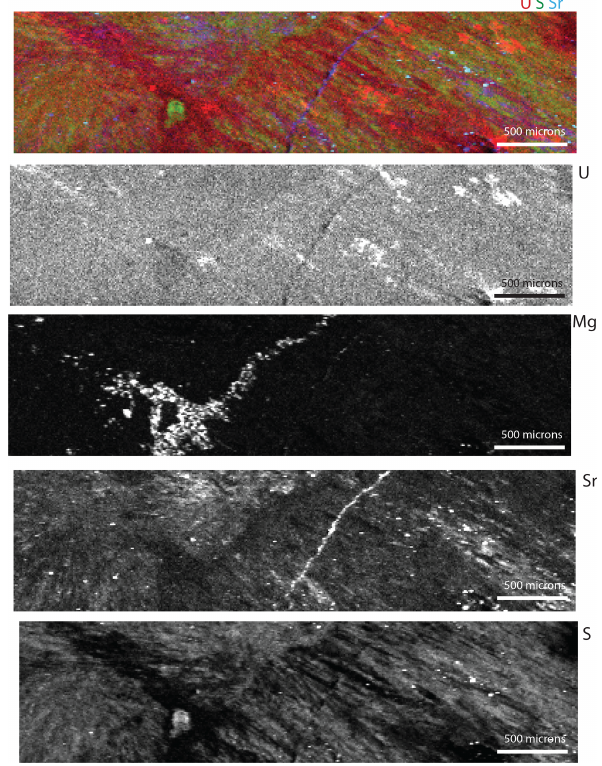
Figure 7. Tender energy range (TES) synchrotron XRF maps of the Walnut Canyon slab shown in Figs. 3–6. The panels are labeled with the elements they represent. The top map is a RGB map where red is U, green is S, and blue is Sr (note the scale bar on the bottom right of the RGB image is 100µm). The brightest areas in the U map are artifacts from diffraction. The best preserved areas are an olive green.